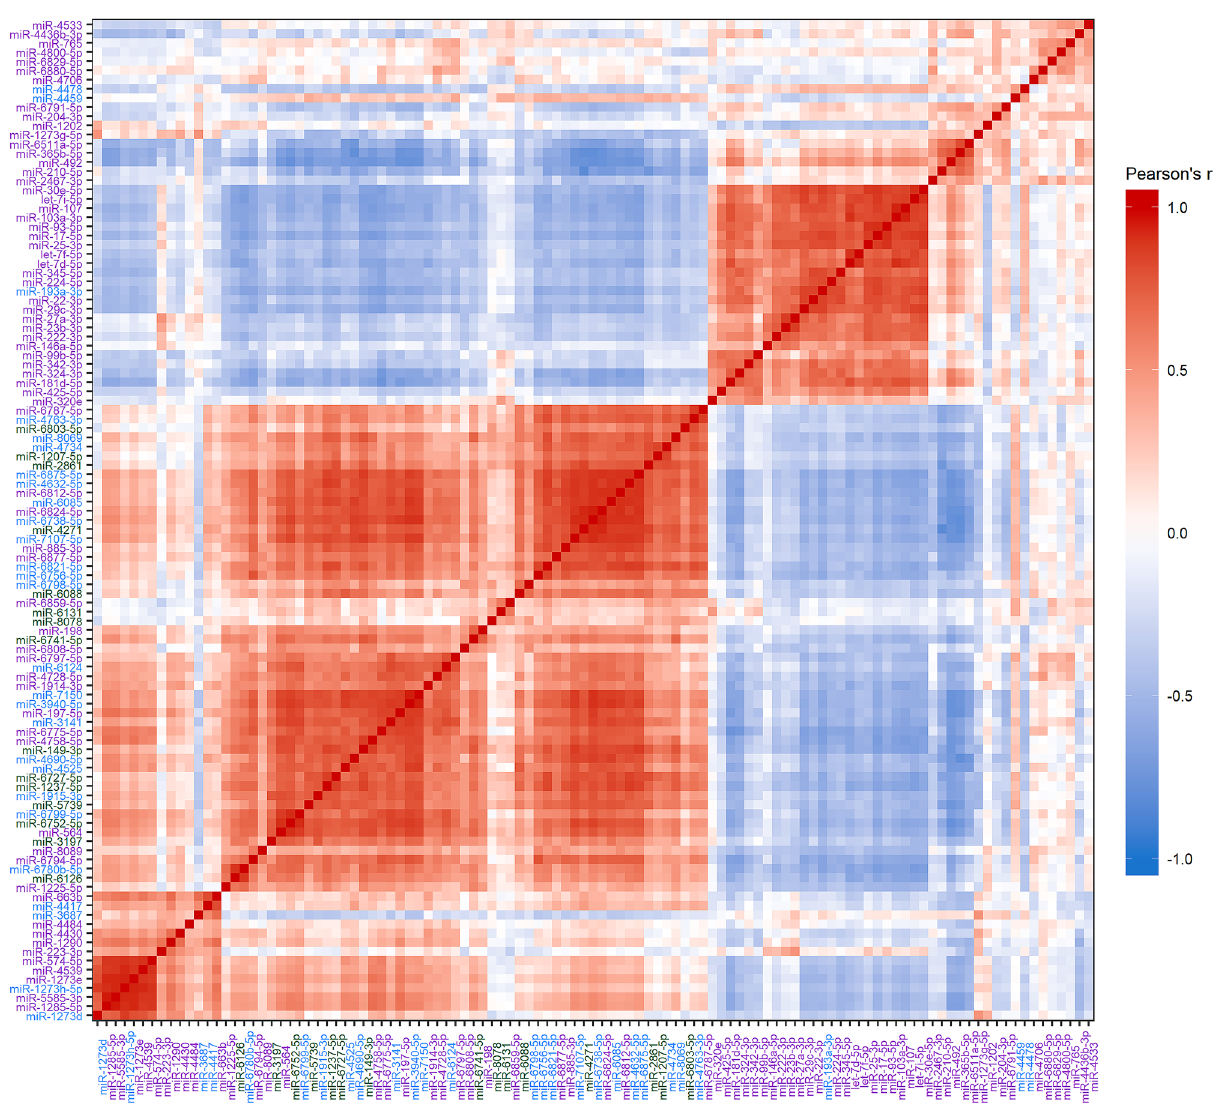
Figure 3. Pearson’s correlations between the 109 miRNAs in the top 3 clusters then re-clustered by correlation coefficient using hierarchical clustering with Euclidian distance and the complete linkage method. Gradient indicates the Pearson’s r with red indicating positive correlations and blue negative correlations. Color of label indicates original cluster membership (Green: Cluster 1; Blue: Cluster 2; Purple: Cluster